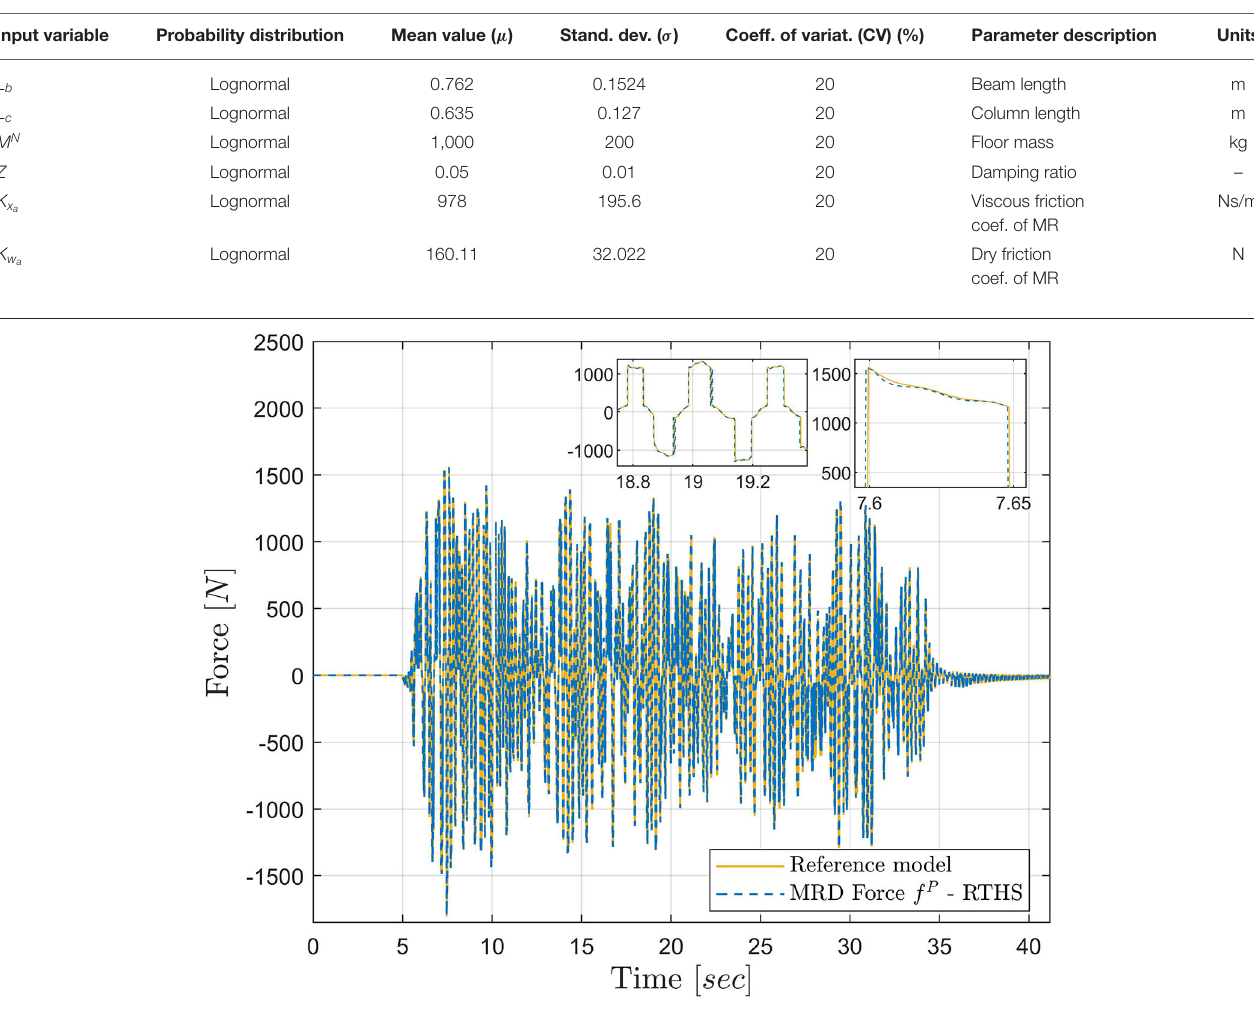
FIGURE 11 | MRD generated force in the reference model and in vRTHS in